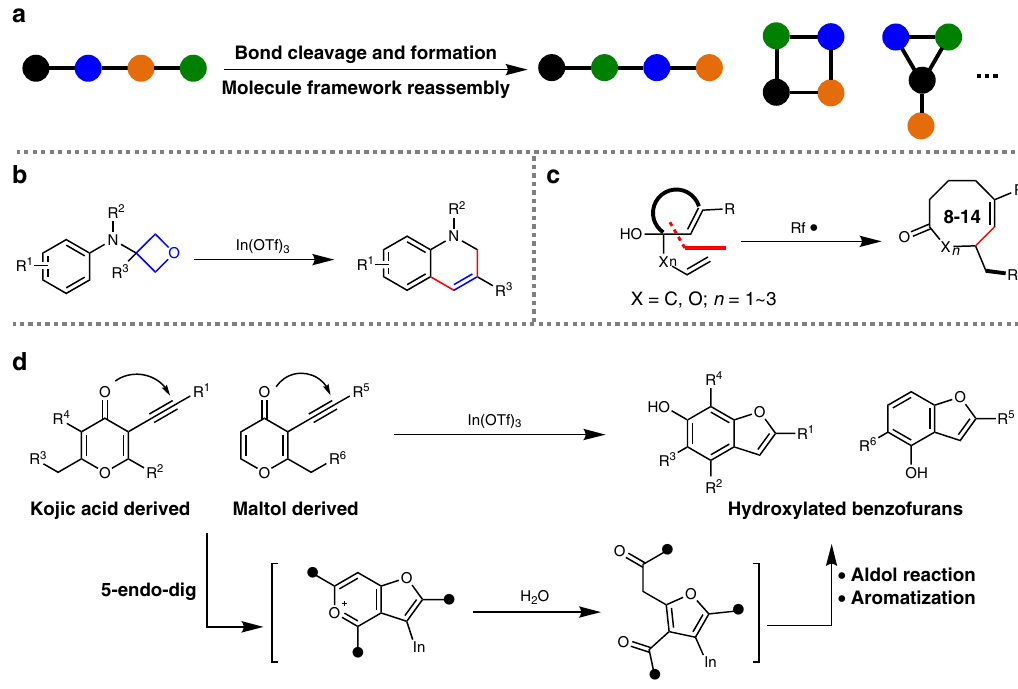
Fig. 1 Skeletal reorganization. a Scheme of a skeletal reorganization in molecules. b In-catalysed skeletal reorganization of oxetanes. c Radical-initiated skeletal reorganization of ole fi nes. d In-catalysed skeletal reorganization of kojic acid- or maltol-derived